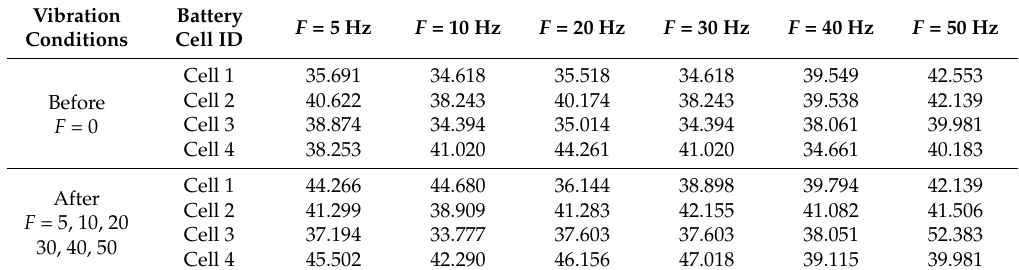
Table 7. The resistance of batteries under no vibration and vibration conditions with different vibration frequency of 5 Hz/10 Hz/20 Hz/30 Hz/40 Hz/50